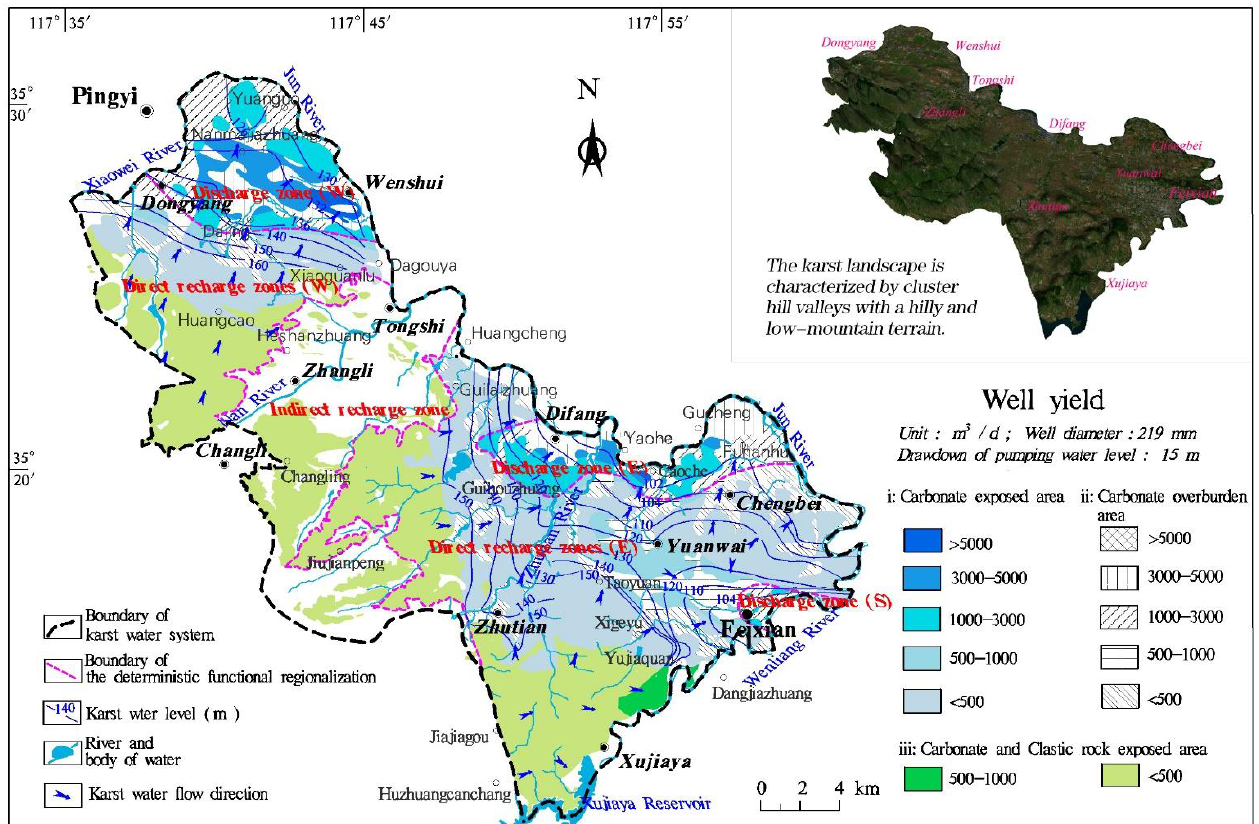
Figure 2. Zoning of the study region based on the hydrochemical characteristics of karst water.